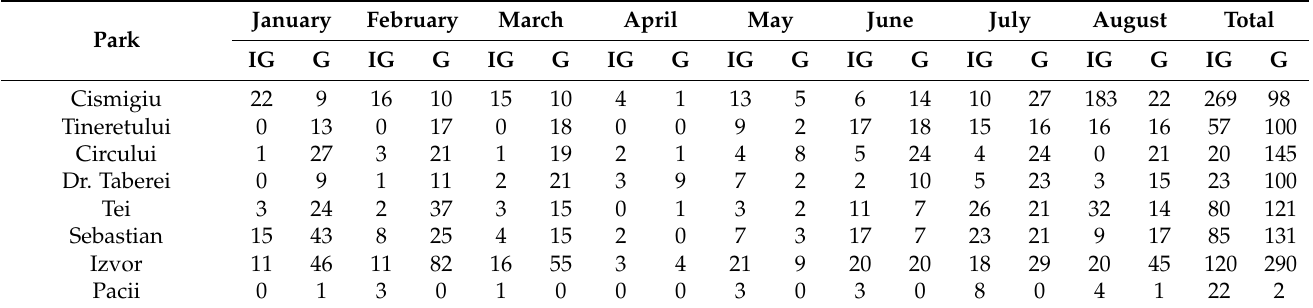
Table 2. The number of recordings for the analyzed parks on Instagram (IG) and Google (G).